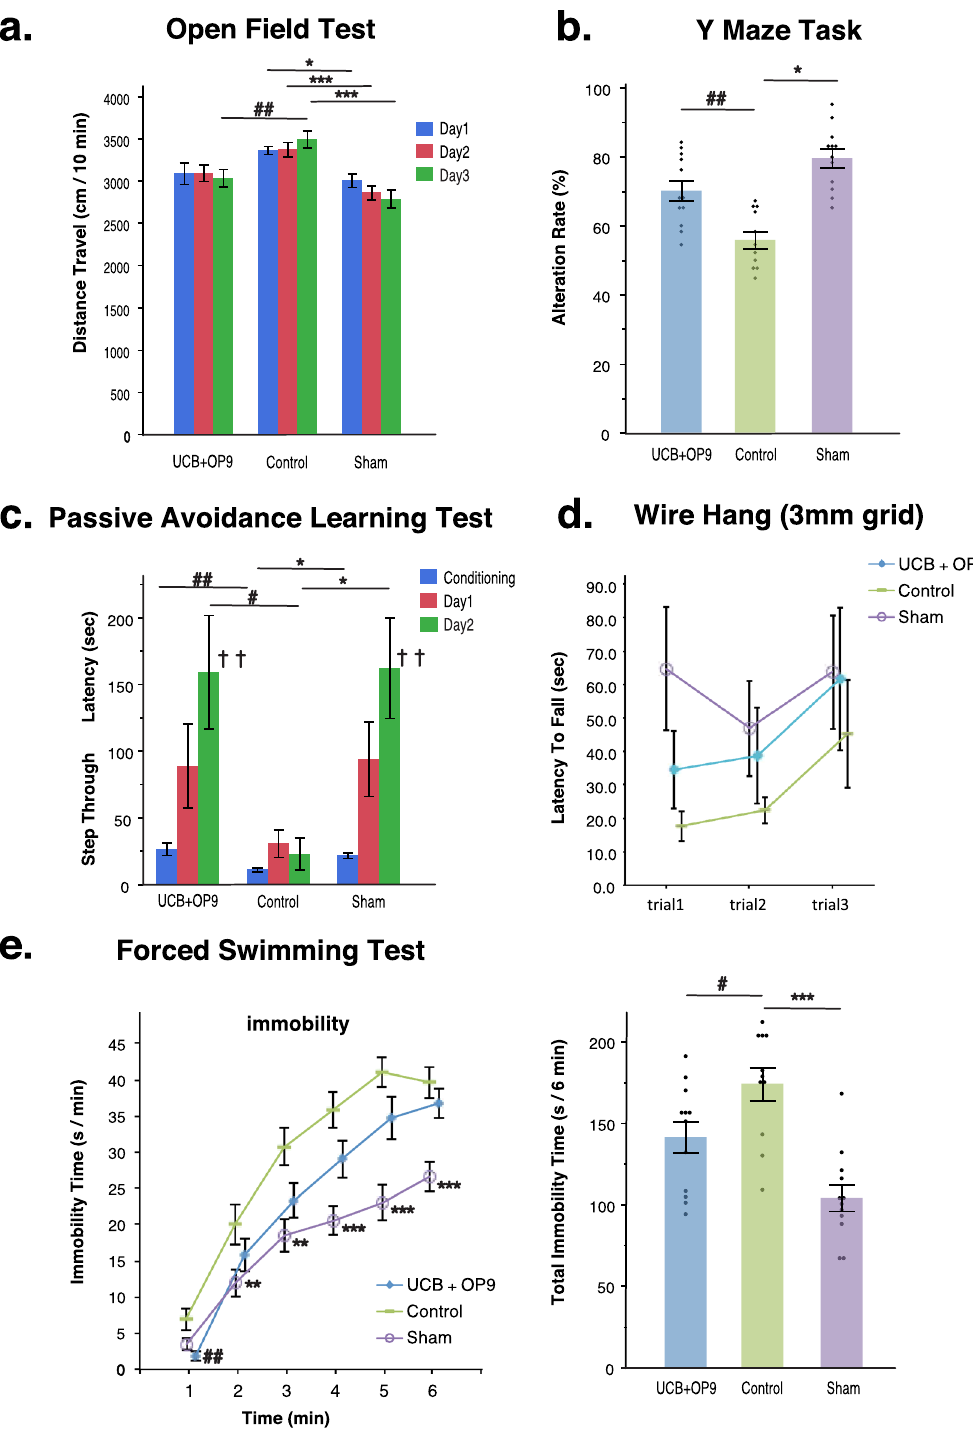
Figure 5. Behavioral tests for MCAO mice with or without OP9-pre-conditioned UCB administration. Mice were randomly assigned to three groups: the UCB + OP9 group (n = 11), the control group (n = 11), and the sham surgery group (n = 12). The open field test ( a ), the Y-maze task ( b ), the passive avoidance learning test ( c ), the wire hang test ( d ), and the forced swimming test were conducted 1.5 month after the surgery. Before multiple comparisons, one-way analysis of variance for the Y-maze task and a two-way repeated measured ANOVA for data arising from repeated measures (i.e., the open field test, passive avoidance learning task, wire hang test, and the forced swimming test) were used. A; p < 0.05, Dunnett’s test for differences between-subject. * p < 0.05, ** p < 0.01, *** p < 0.001, Dunnett’s test in comparison of the sham surgery group with the control group (i.e., the MCAO induced group). # p < 0.05, ## p < 0.01, Dunnett’s test in comparison of the OP9 + UCB group (i.e., the MCAO induced and OP9-pre-conditioned UCB-administered group) with the control group. † p <